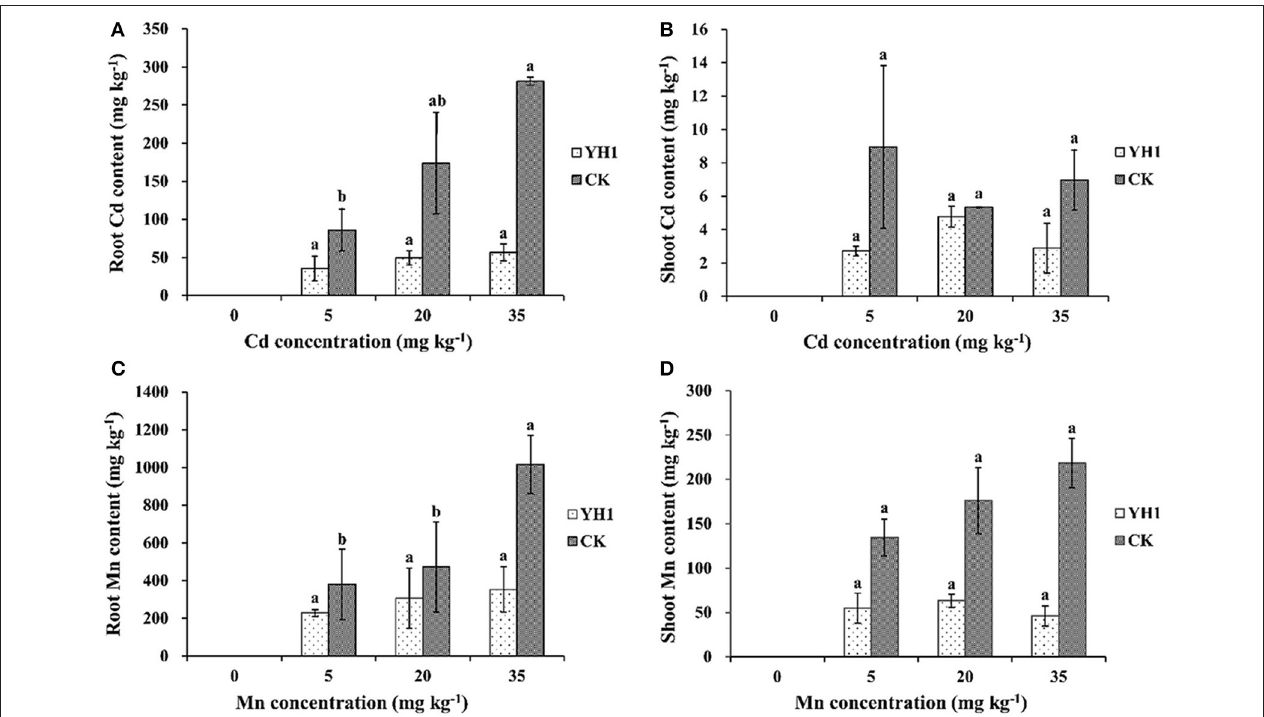
FIGURE 5 | Cd contents in (A) shoot and (B) root, Mn contents in (C) root and (D) shoot of L. leucocephala after 6 months growth in vermiculite supplemented with three different concentrations of Cd or Mn. YH1, plants inoculated with strain YH1; CK, control group without inoculation. Different lowercase letters following data in either the YH1-inoculated or the YH1-free control group treated with different concentrations of the same metal show the statistical difference is significant at P < 0.05 according to LSD test. Error bars represent standard